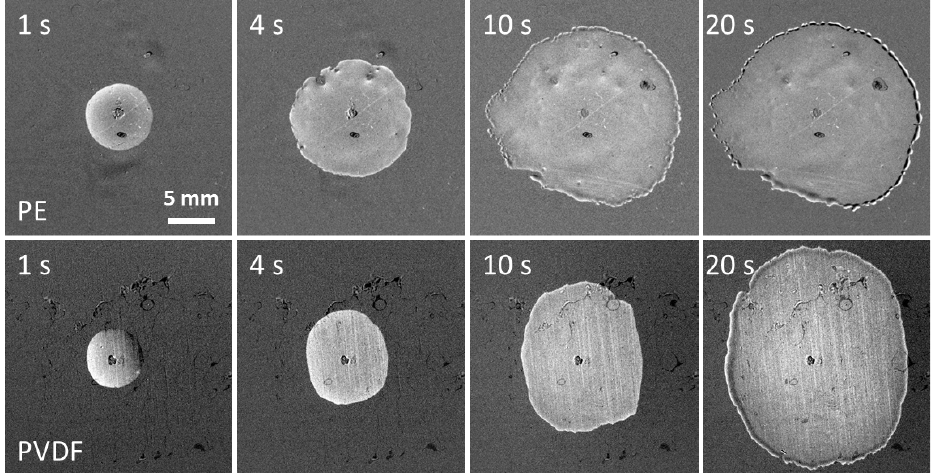
Figure 5. Spreading patterns formed by a 5 μ L drop of 5 g/L solution of BT-278 in 30% glycerol/water mixture on PE (top row) and PVDF (bottom row) substrate.